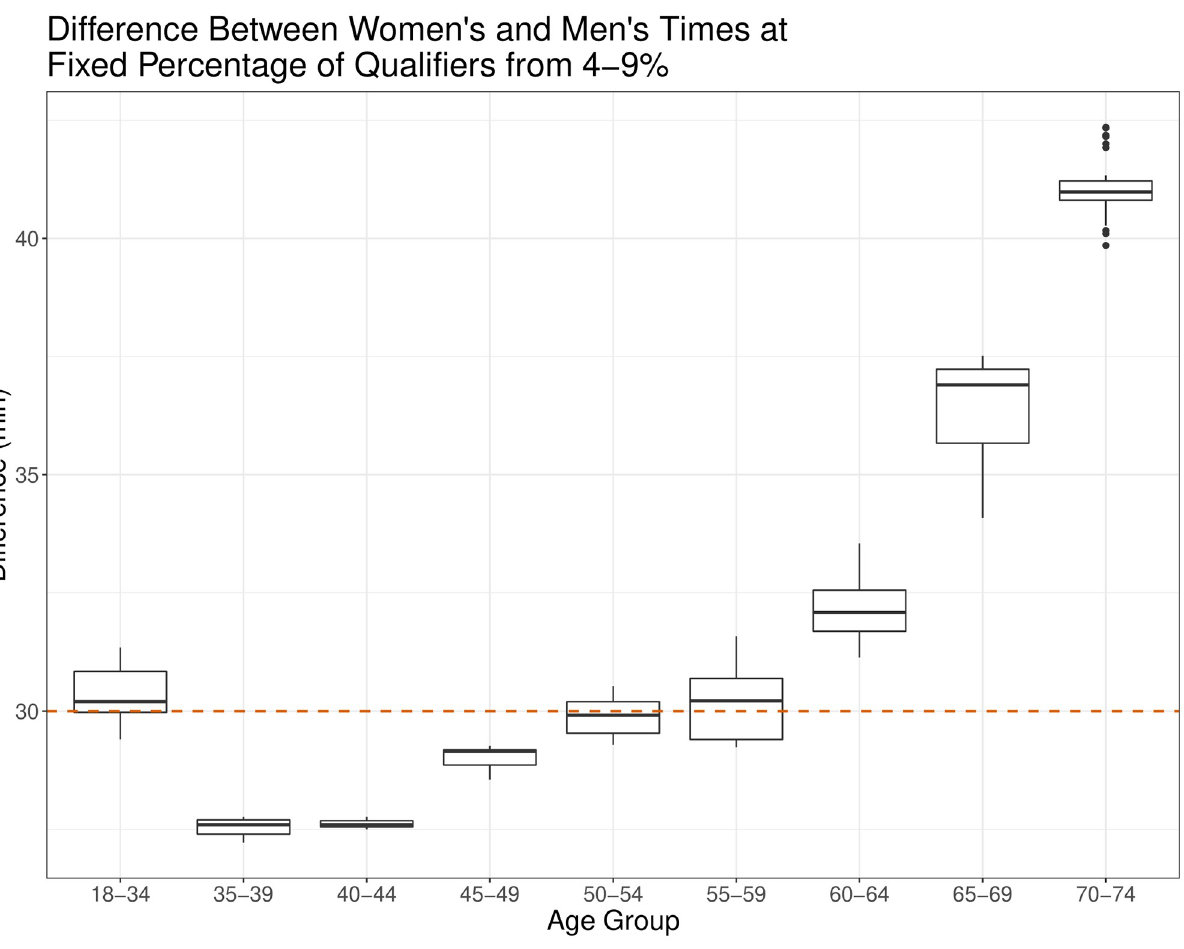
Fig 2. Difference between men’s and women’s times for the top 4–9% of runners at each 0.1% increment in each age group. The red line indicates the 30-minute difference which is currently used in each age group.